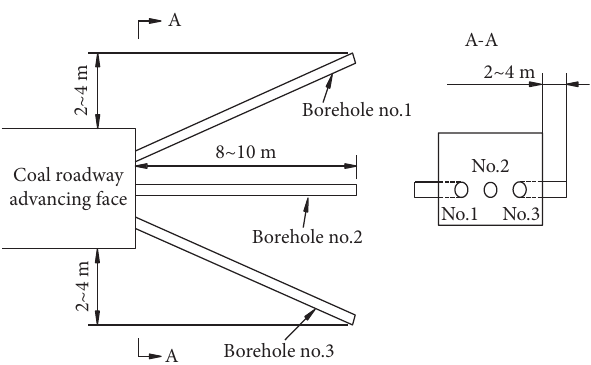
Figure 1: Borehole layout for outburst risk prediction in coal roadway advancing